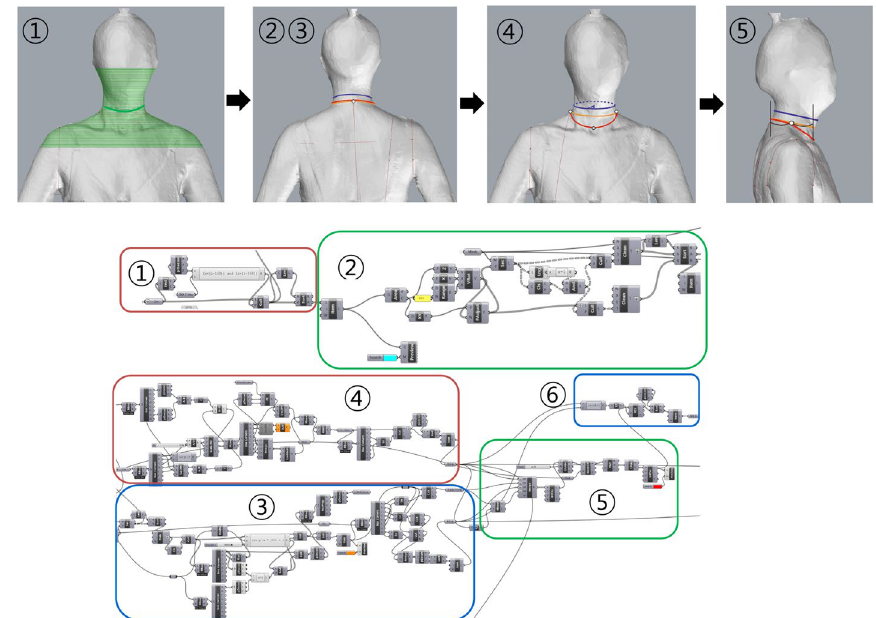
Fig. 2 Grasshopper algorithm for extracting neck